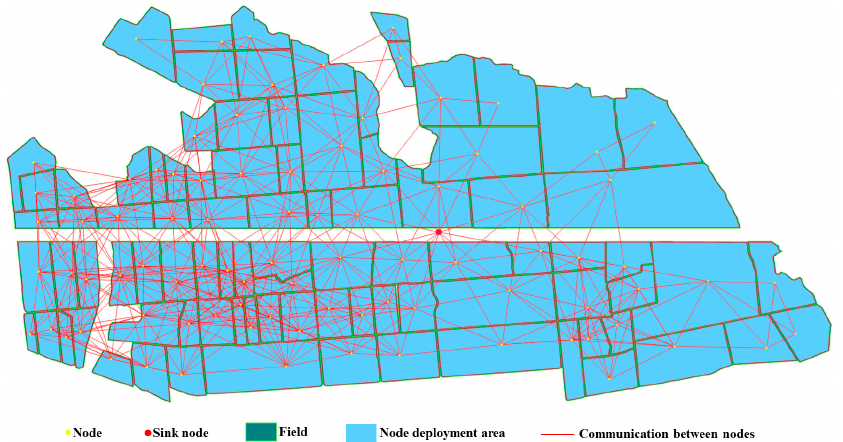
Figure 15. The WSN deployment on natural farmland located in Nanjing, Jiangsu Province, China. The communication distance is 200 m, and the connectivity is two.